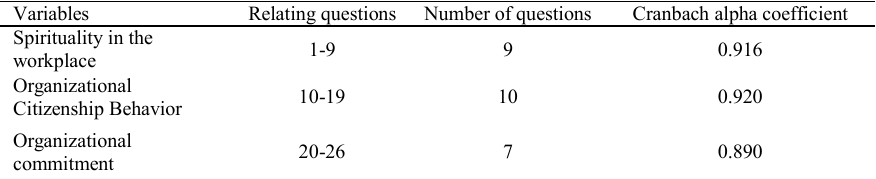
Table 1: Variables and coefficient of their reliability